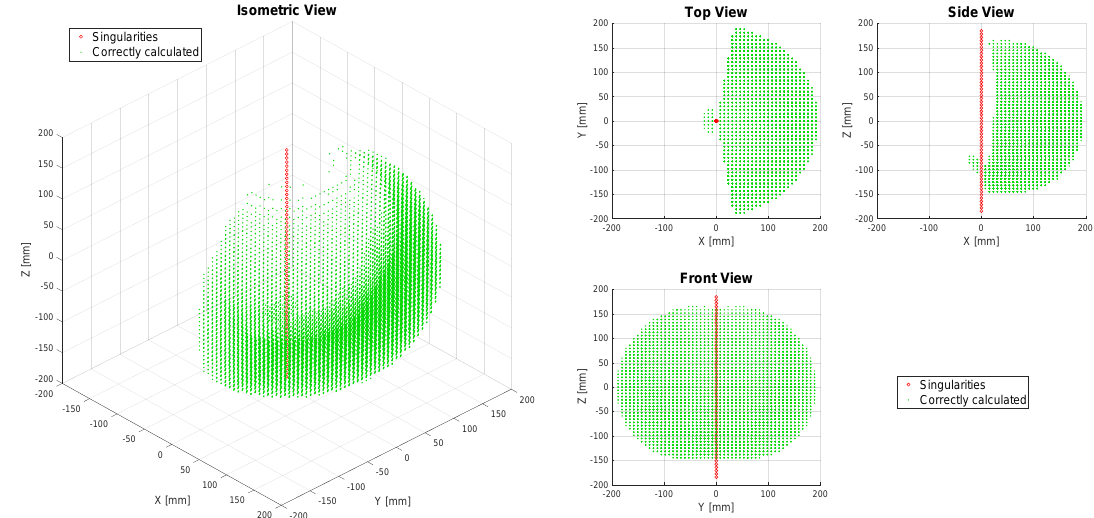
Figure 10. Performance analysis of the synthesized IKM for the hexapod’s leg. The left side shows the isometric view of the leg’s workspace, while the right side presents the top, side, and front views of the same workspace. Marked in green (“Correctly calculated”) are all the the positions in which the IKM obtains the same amount of solutions as the reference model, with an RMS error lesser than 1 × 10 − 8 . The red circles correspond to the singularities of the leg’s mechanism that are correctly identified by the synthesized IKM. The data show that all the positions of the analyzed workspace are correctly calculated.